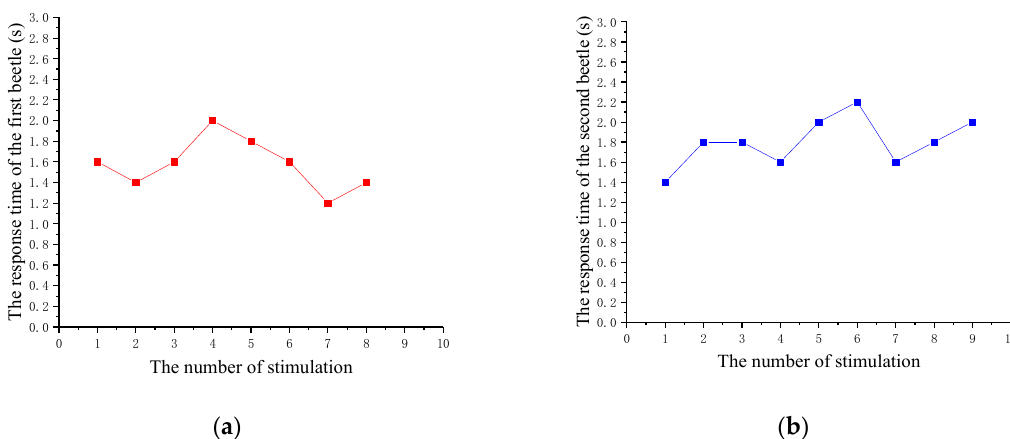
Figure 8. The response time of two beetles to each stimulation experiment. ( a ) The response time of the first beetle; ( b ) the response time of the second beetle.